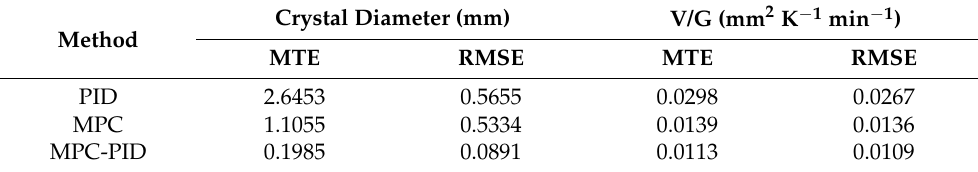
Table 3. MTE and RMSE of control output error under sinusoidal noise.